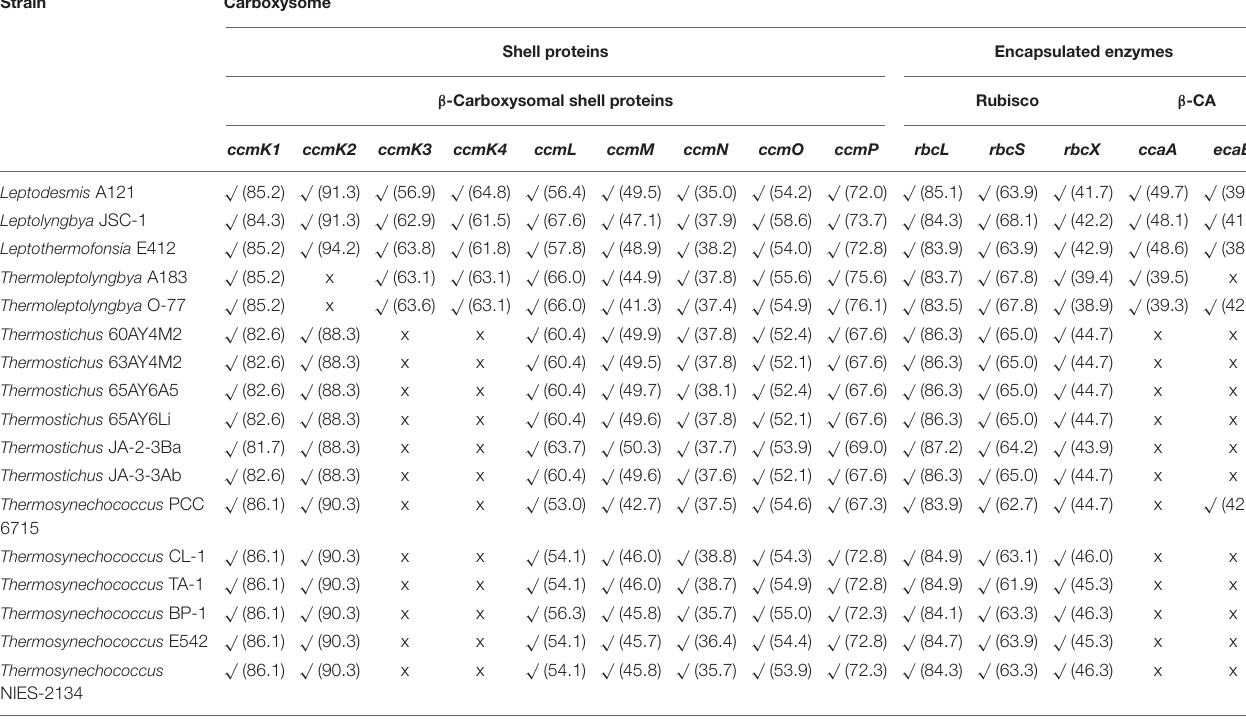
TABLE 3 | Availability of genes encoding carboxysomes of thermophilic cyanobacteria studied. Strain Carboxysome